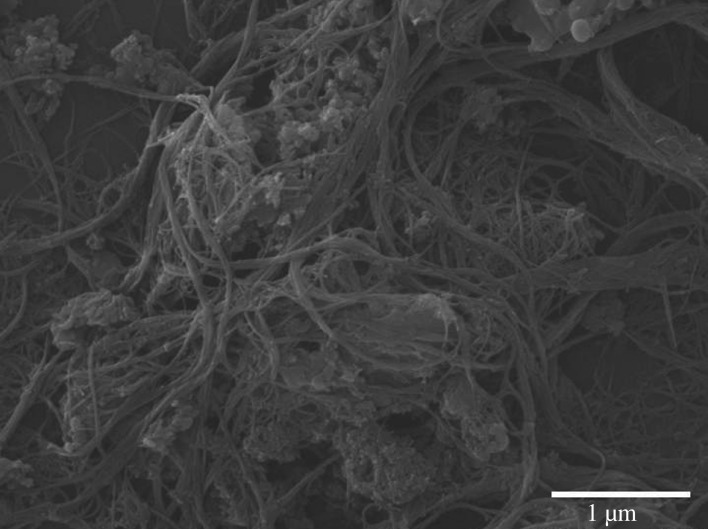
SEM image of C60/CNTs/g-C3N4 composite after photocatalysis.